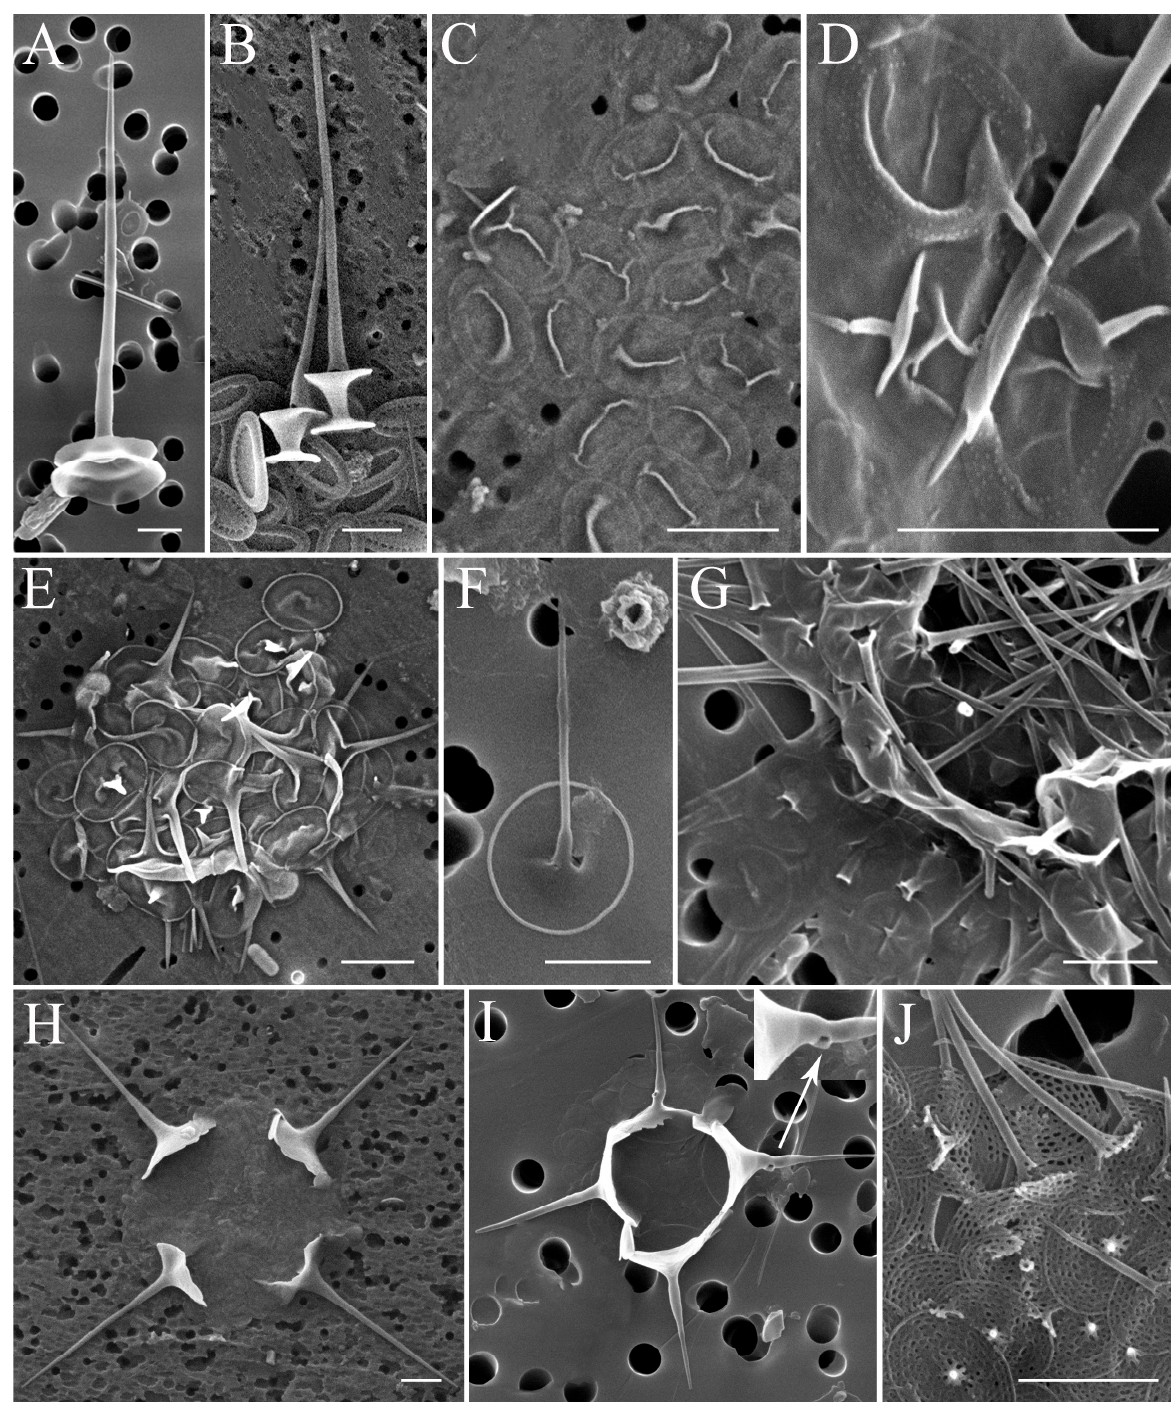
Figure 2. Silica-scaled chrysophytes from lakes Labynkyr and Vorota. SEM: ( A ) Chrysosphaerella coronacircumspina ; ( B ) C. brevispina ; ( C , D ) Paraphysomonas limbata ; ( E ) P. gladiata ; ( F , G ) P. uniformis hemiradia ; ( H ) Spiniferomonas bourrellyi ; ( I ) S. cf. bourrellyi with pores ; ( J ) Lepidochromonas takahashii. Scale bars: 2 μ m.